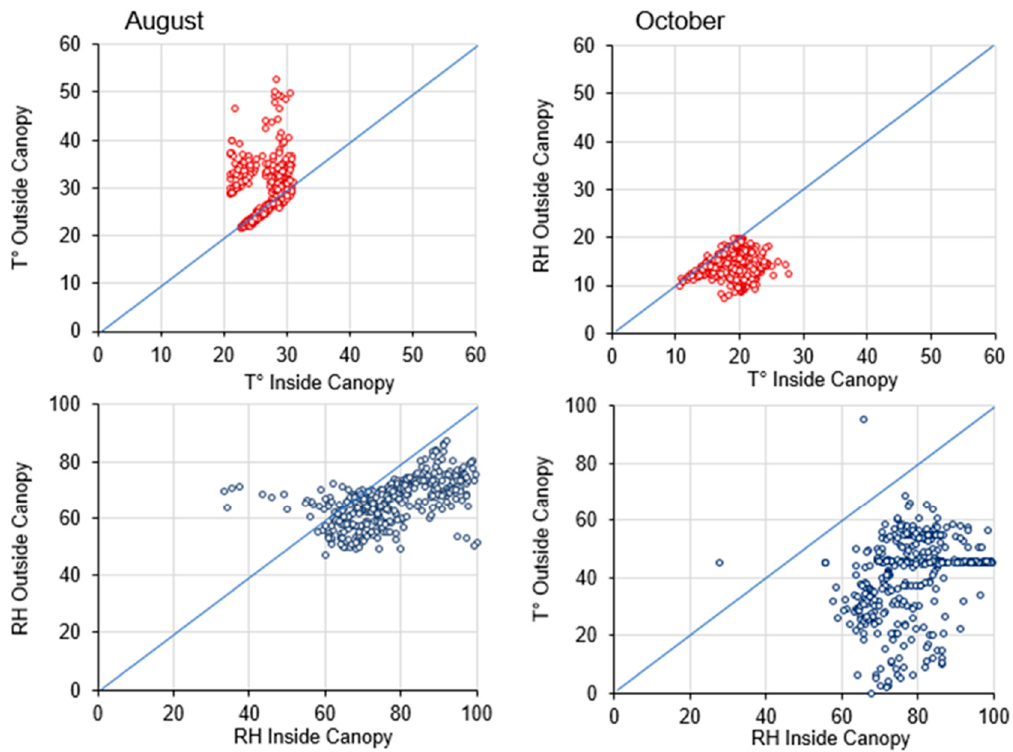
Figure 9. Scatter plot of temperature (°C) and relative humidity (%) inside and outside a vineyard canopy in August and October. Data refer to values recorded every hour during the whole recording month. Values over the 1:1 indicate that the variable has the same values in the different conditions, while values above or below the line highlight that the temperature or relative humidity are higher or lower outside the canopy, respectively.